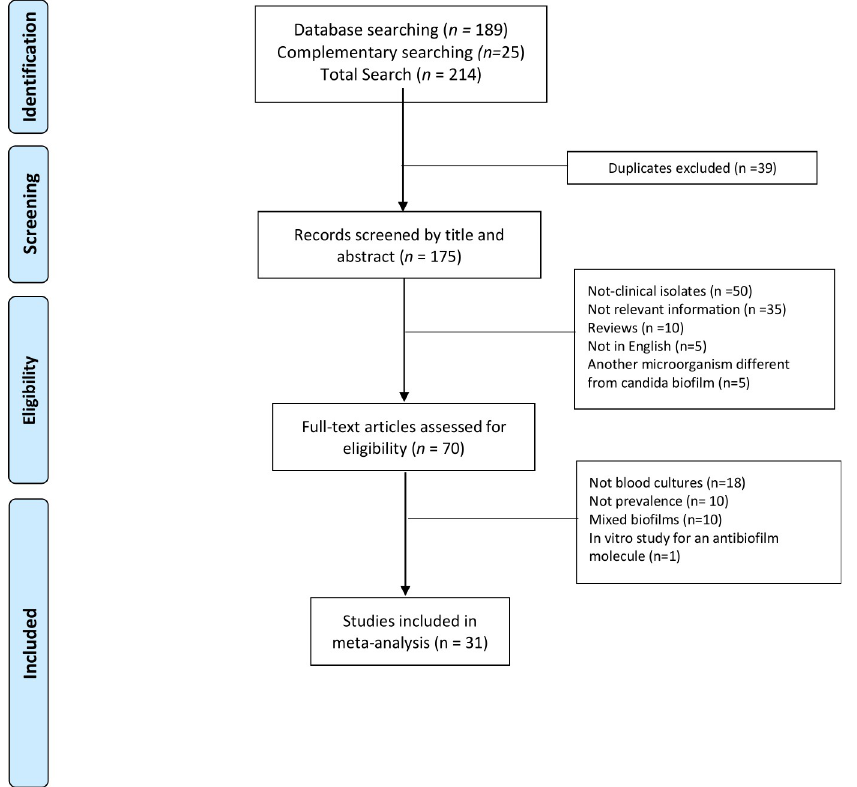
Fig 1. Prisma flow chart of included and excluded studies of the selection